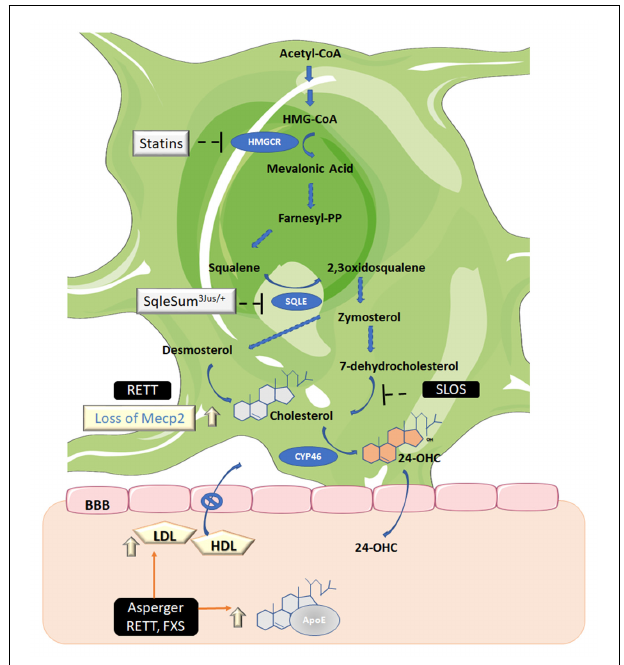
FIGURE 2 | Biosynthetic and catabolic pathways in the brain. Cholesterol is the end product of the mevalonate pathway. Three molecules of acetyl-coenzyme A (acetyl-CoA) are required to generate 3-hydroxy-3-methyl-glutaryl CoA (HMG-CoA) which is the substrate of HMG-CoA reductase (HMGCR), the mevalonic acid-generating enzyme. This is the only limiting rate reaction in cholesterol synthesis and is the target of statins, the cholesterol-lowering drugs. Mevalonic acid is then converted to farnesyl diphosphate (farnesyl-PP) and squalene. The latter is then converted to 2,3 oxidosqualene by squalene epoxidase (SQLE). Then a series of enzymes catalyzes the synthesis of zymosterol, which can, in turn, be converted to cholesterol via desmosterol by 24-dehydrocholesterol reductase, also known as the Bloch pathway (operating in astrocytes) or via lathosterol (not shown), which is the precursor of 7-dehydrocholesterol, also known as the Kandutsch-Russell pathway (the minority pathway in neurons). The enzyme 7-dehydrocholesterol reductase, which converts 7-dehydrocholesterol to cholesterol, is defective in patients with SLOS. Cholesterol, in turn, must be converted to 24- S -hydroxycholesterol (24-OHC) by 24-hydroxylase (CYP46) to be able to permeate the blood-brain barrier (BBB). Asperger syndrome (Asperger); Smith–Lemli–Opitz syndrome (SLOS); Rett syndrome (RETT); Fragile-X syndrome (FXS); Apolipoprotein E (ApoE); methyl CpG binding protein 2 (Mecp2); low-density lipoproteins (LDL); high-density lipoproteins (HDL). Figure created using Servier Medical Art Commons Attribution 3.0 Unported License (http://smart.servier.com). Servier Medical Art by Servier is licensed under a Creative Commons